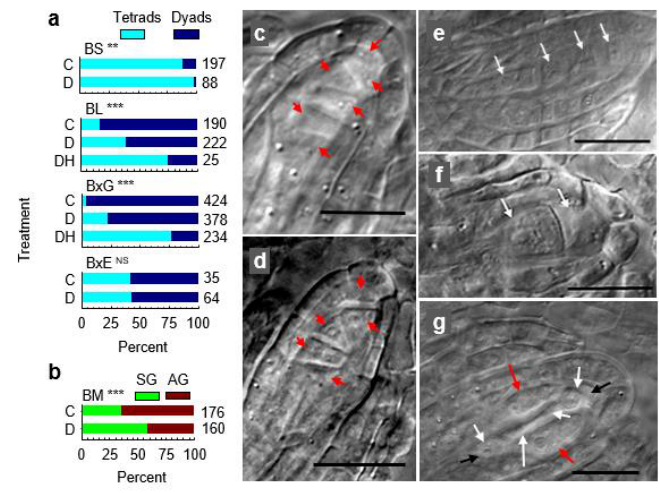
Figure 8. Effects of no stress (C), drought (D) and drought plus heat (DH) on ( a ) percentages of meiotic or apomeiotic dyads and meiotic tetrads in sexual Boechera stricta (BS), facultatively diplosporous Boechera lignifera (BL), triploid and nearly obligately diplosporous Boechera cf. gunnisoniana (BxG), and facultatively diplosporous Boechera exilis × retrofracta (BxE); ( b ) percentages of aposporous (AG) and sexual (SG) gametophyte formation in aposporous Boechera microphylla (BM); ( c , d ) meiotic hexad and pentad of megaspores from stress-induced meioses in triploid diplosporous B. cf. gunnisoniana ; ( e ) meiotic tetrad of megaspores from sexual B. stricta ; ( f ) diplosporous dyad from diplosporous B. lignifera ; ( g ) degenerating tetrad (between black arrows) of Millard County B. microphylla with early vacuolate, 1-2 nucleate aposporous gametophytes on each side (red arrows). Numbers of ovules examined in ( a ) and ( b ) that contained scorable dyads, tetrads, SGs, and AGs per treatment are indicated at the right of the colored bars; cytology bars, 20 µ m. Chi-square p values: **, *** are 0.01, 0.001; NS, not significant.